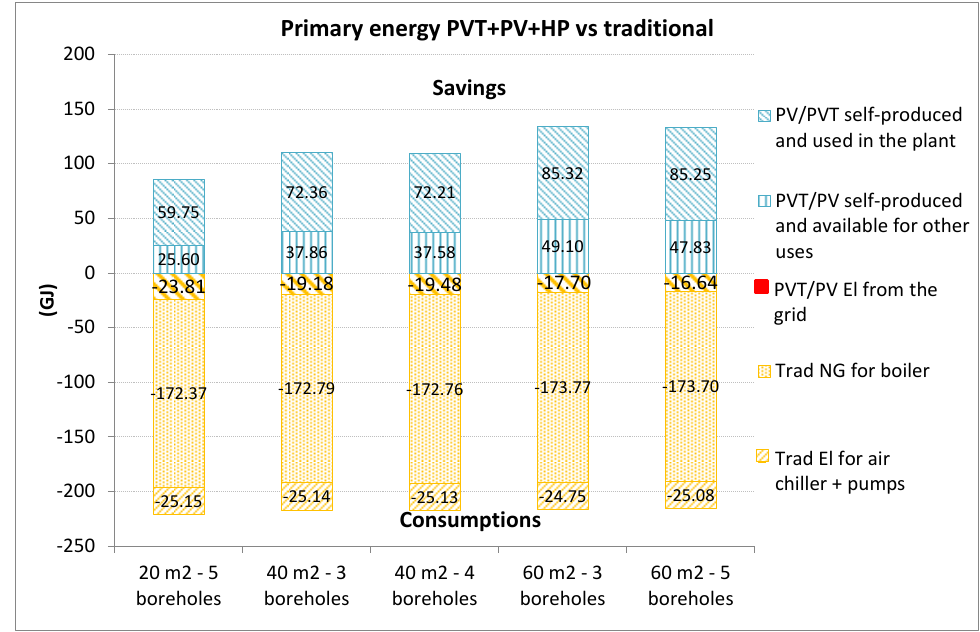
Figure 12. Non-renewable primary energy comparison between the five considered different alternatives, each compared with the conventional solution.